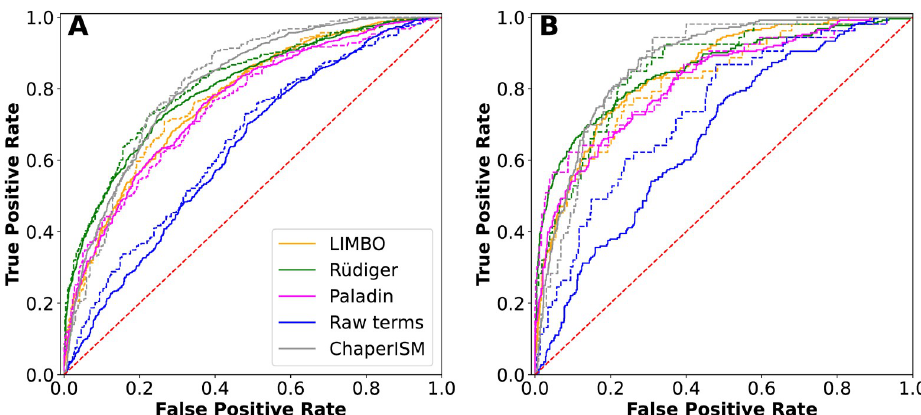
Fig 5. Receiver operating characteristic curves of various predictors. The raw score was calculated using the energy terms with uniform weights. (A) Discrimination of both strong binders and binders from nonbinders, and (B) Discrimination of strong binders from nonbinders. All solid lines were derived from the training set and dotted lines from the validation set. The red dashed diagonal line represents a random prediction.